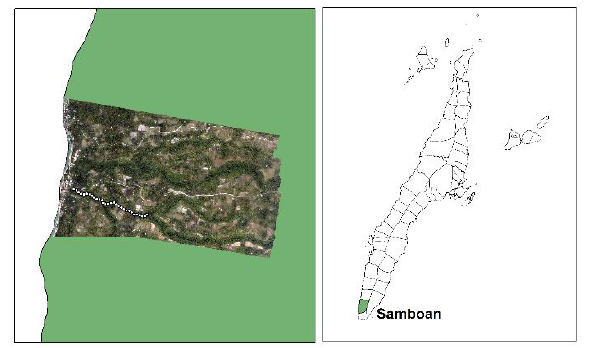
Figure 1. Location map of Tangbo River, Samboan, Cebu